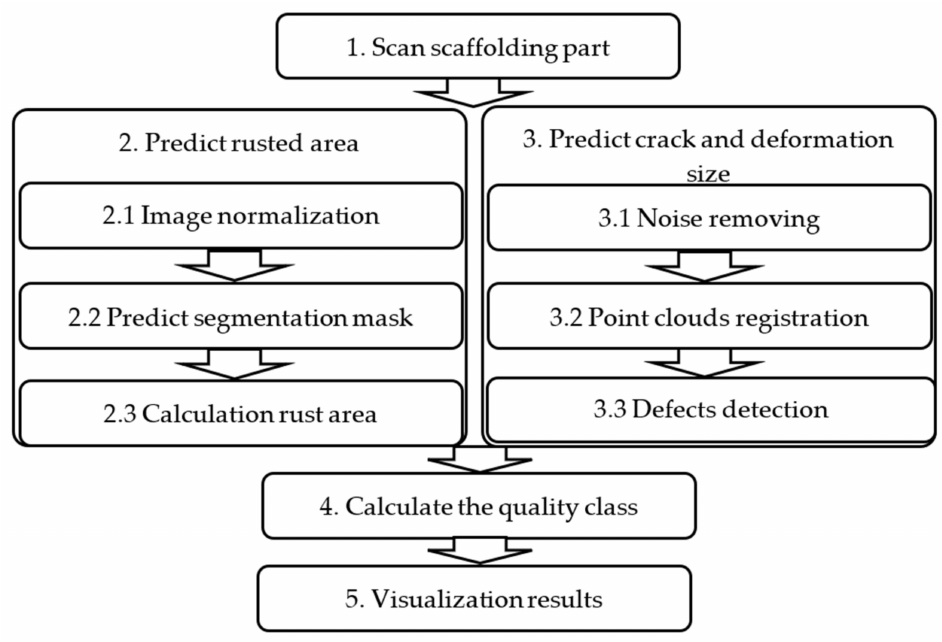
Figure 1. Quality classification flow